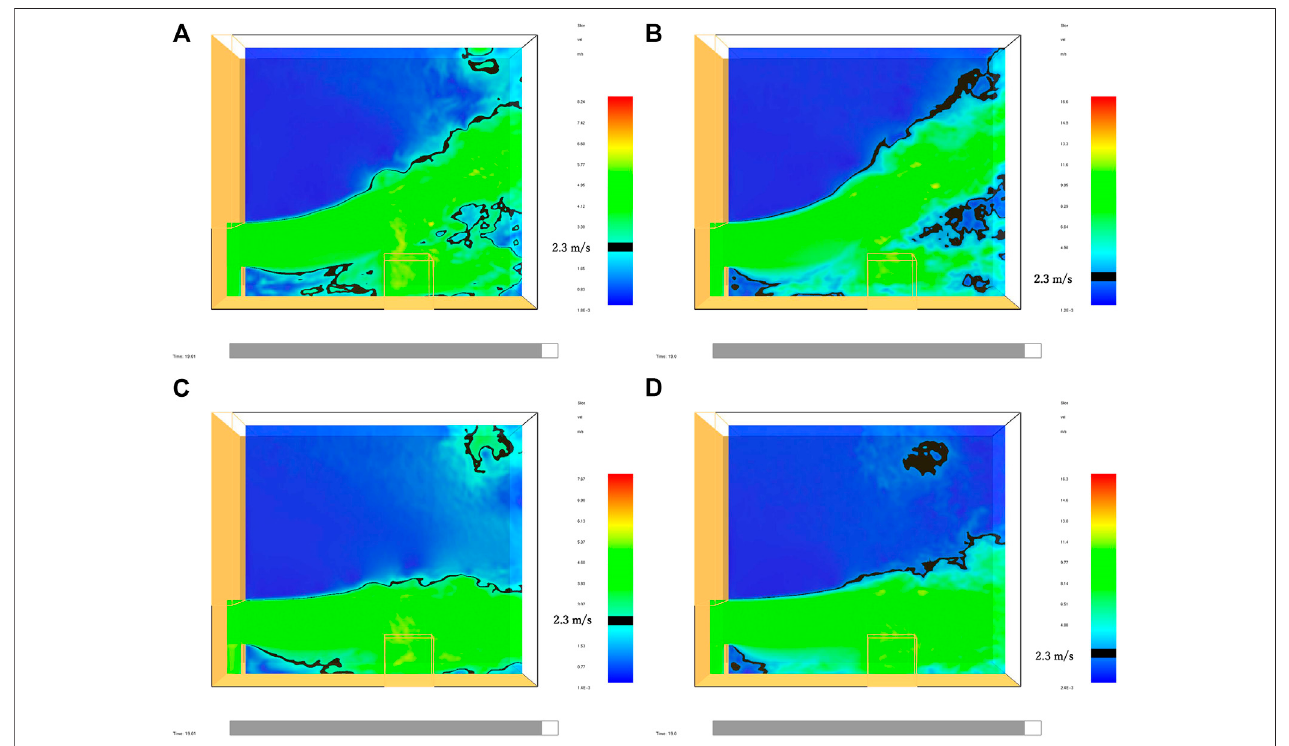
FIGURE9| FDSsimulationresultswithdifferentSDandwindspeeds.Windpro fi leatcenterline.Blacklineintheimagesshowswindspeedofaround2.3m s − 1 (A)